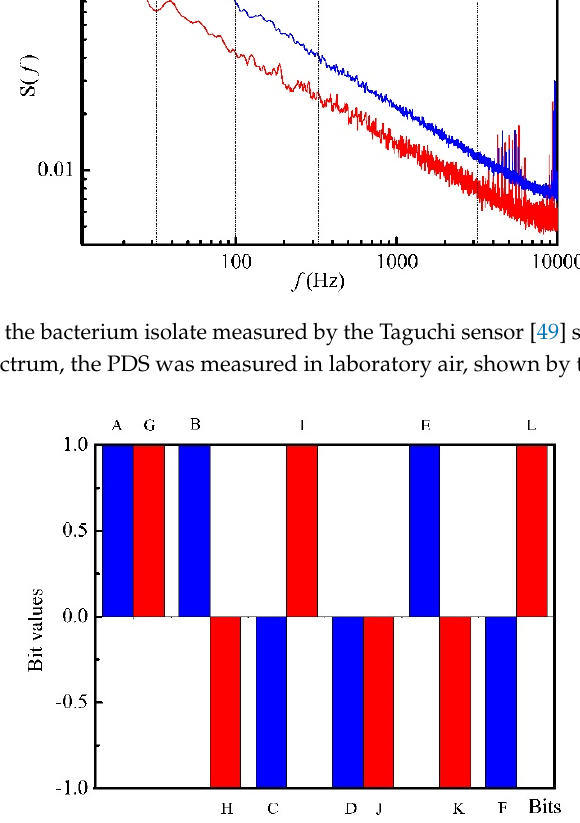
Figure 7. Reproducibility of the binary fingerprints. Red: measurement-1; blue: measurement-2 (of the same sample). Figure 8. Reproducibility of the ternary fingerprints. Orange: measurement-1; maroon: measurement- 2 (of the same sample).